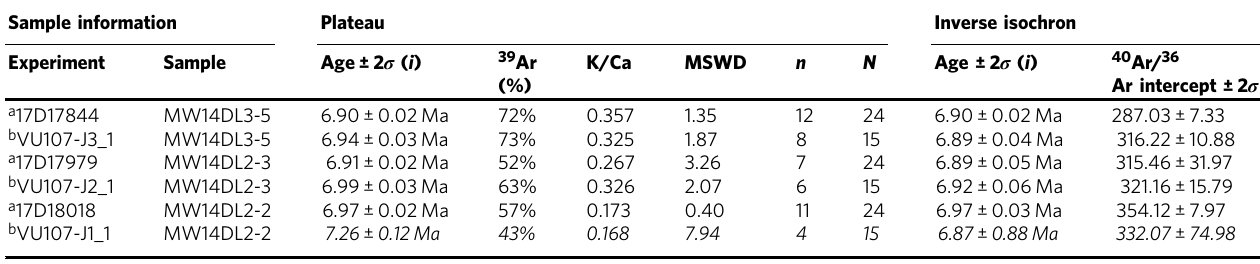
Table 1 Results of 40 Ar/ 39 Ar groundmass incremental heating experiments for S0230 samples. Sample information Plateau Inverse isochron